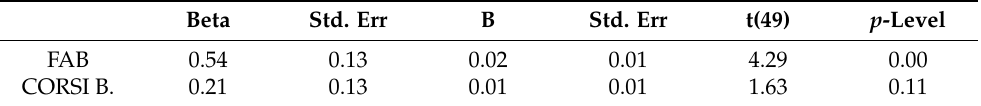
Table 2. The table shows the relationship between participants’ performance at both FAB and Corsi Backward and accuracy of allocentric judgments. The parameters of predictors of the outcome variable are reported.